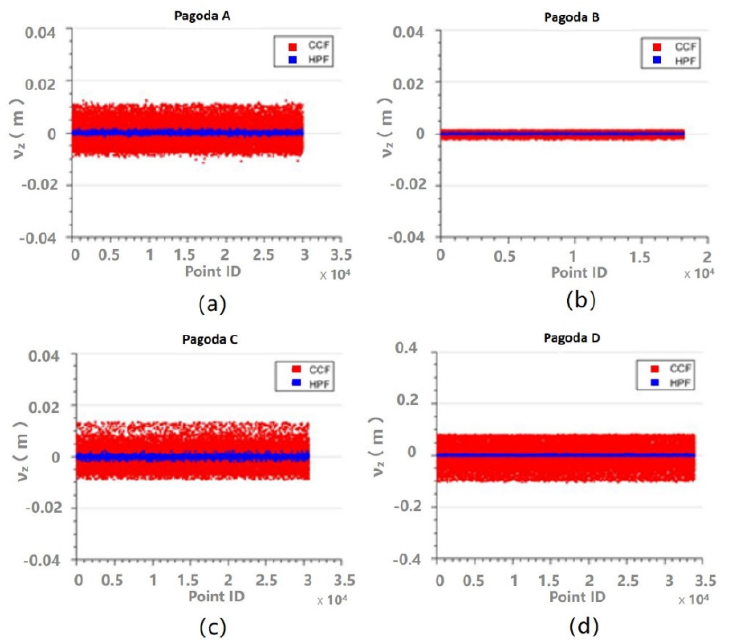
Figure 11. Residuals of z for the CCF (red) and the HPF (blue) for Part 3: ( a ) Pagoda A; ( b ) Pagoda B; ( c ) Pagoda C; and ( d ) Pagoda D.